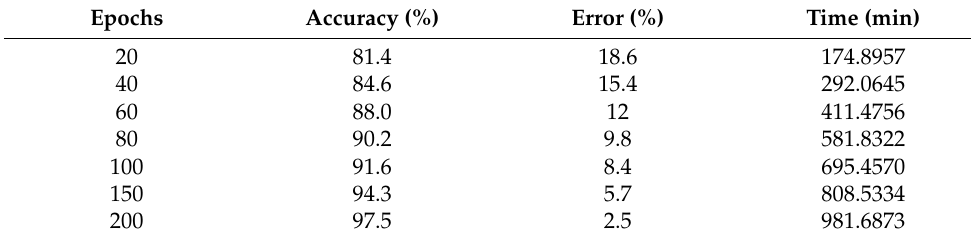
Table 9. Training accuracy on selected hyper parameters using CASIA B